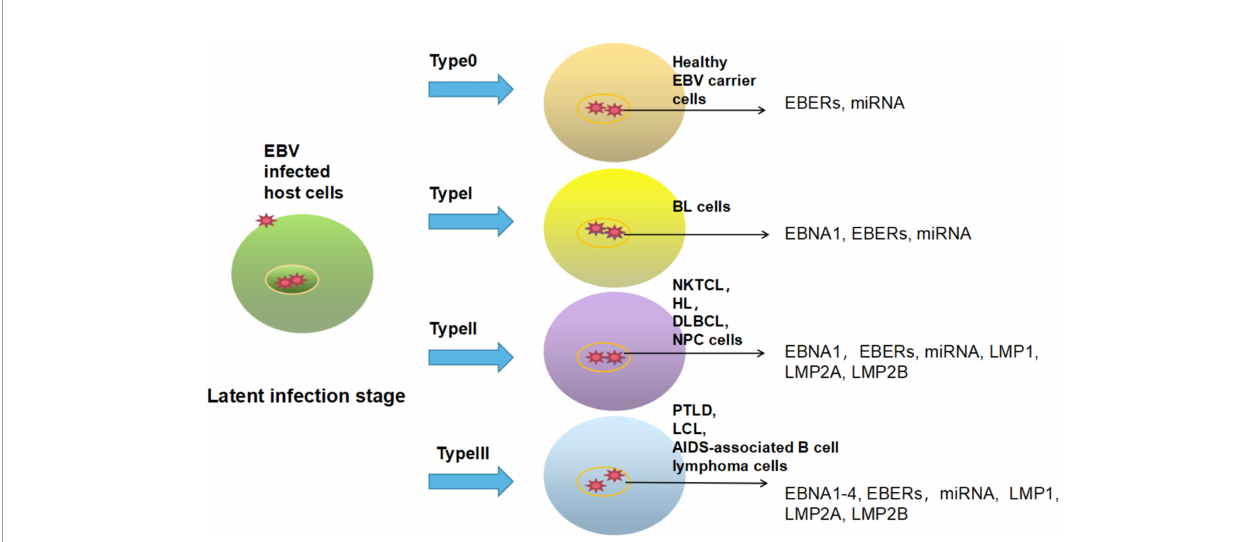
FIGURE 1 | EBV expresses different viral proteins in different host cells during a latent infection. Latent type 0: EBER and miRNA are expressed in the nucleus of host cells, mainly in EBV carriers in good health. Latent type I: EBNA1, EBER and miRNA are commonly expressed in patients with Burkitt lymphoma (BL) (5). Latent type II: EBNA1, EBER, miRNA, LMP1, LMP2A, and LMP2B are generally expressed in patients with HL, nasal NK/T cell lymphoma (NKTCL), NPC and diffuse large B-cell lymphoma (DLBCL) (6, 7). Latent type III: EBNA1 – 4, EBER, miRNA, LMP1, LMP2A and LMP2B can be expressed in posttransplant lymphoproliferative disease (PTLD), lymphoblastic cell line (LCL) and AIDS-associated B-cell lymphoma